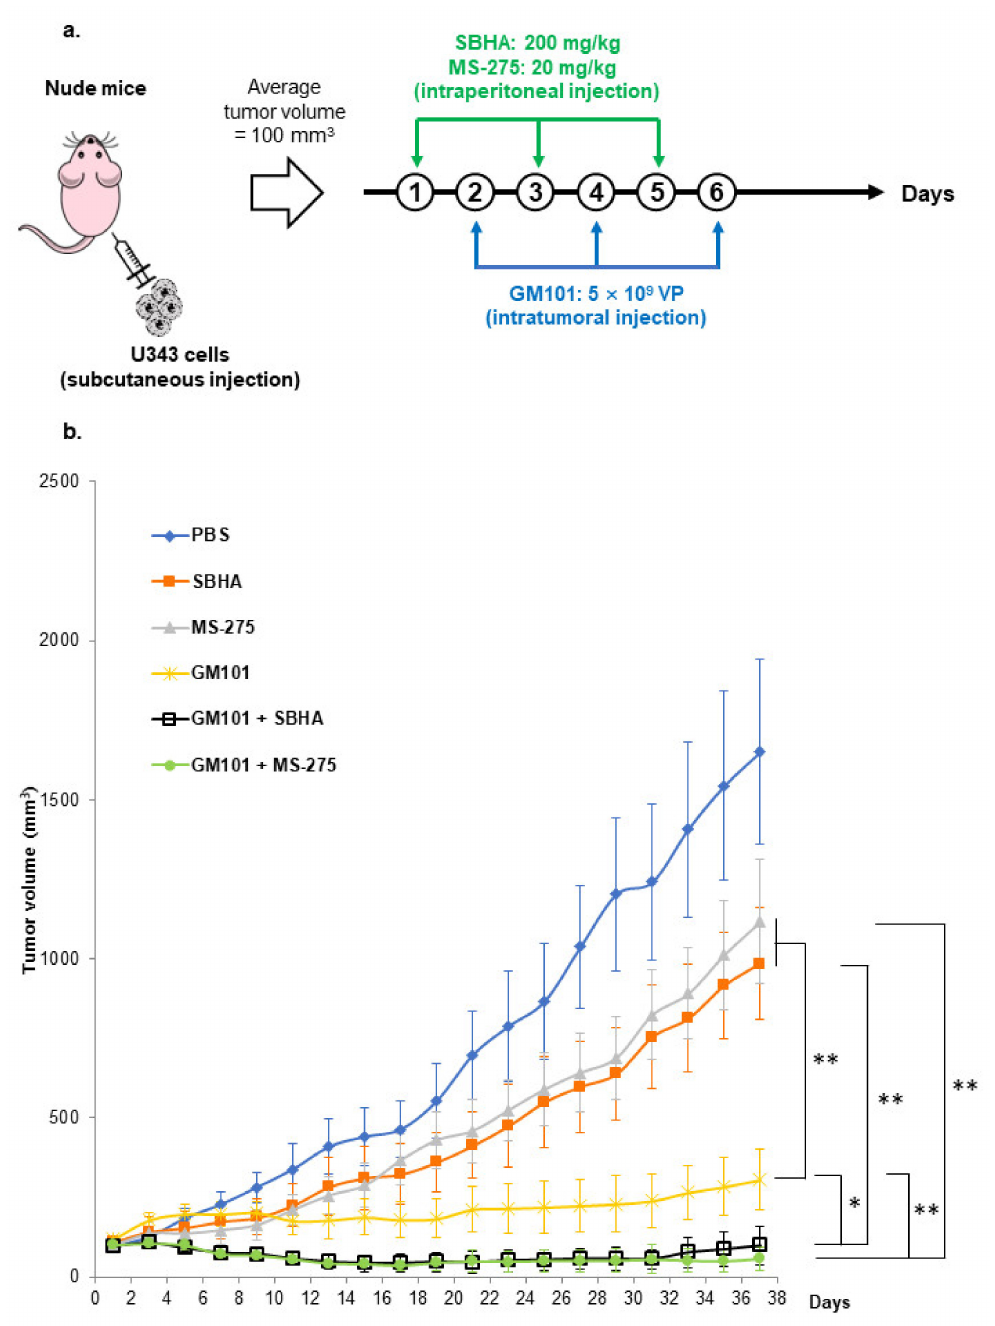
Figure 5. Antitumor effects of GM101 and HDACi combination therapy: ( a ) U343 xenograft tumors were established in nude mice through subcutaneous injection to the abdominal skin. Once the average tumor volume reached 100 mm 3 , tumor-bearing mice were treated with PBS, SBHA (200 mg/kg), MS-275 (20 mg/kg), GM101 (5 × 10 9 VP), GM101+SBHA, or GM101+MS-275. ( b ) Tumor volume was measured every two days by caliper. Results are expressed as the mean ± SD (each group, n = 6). * P < 0.05, ** P <